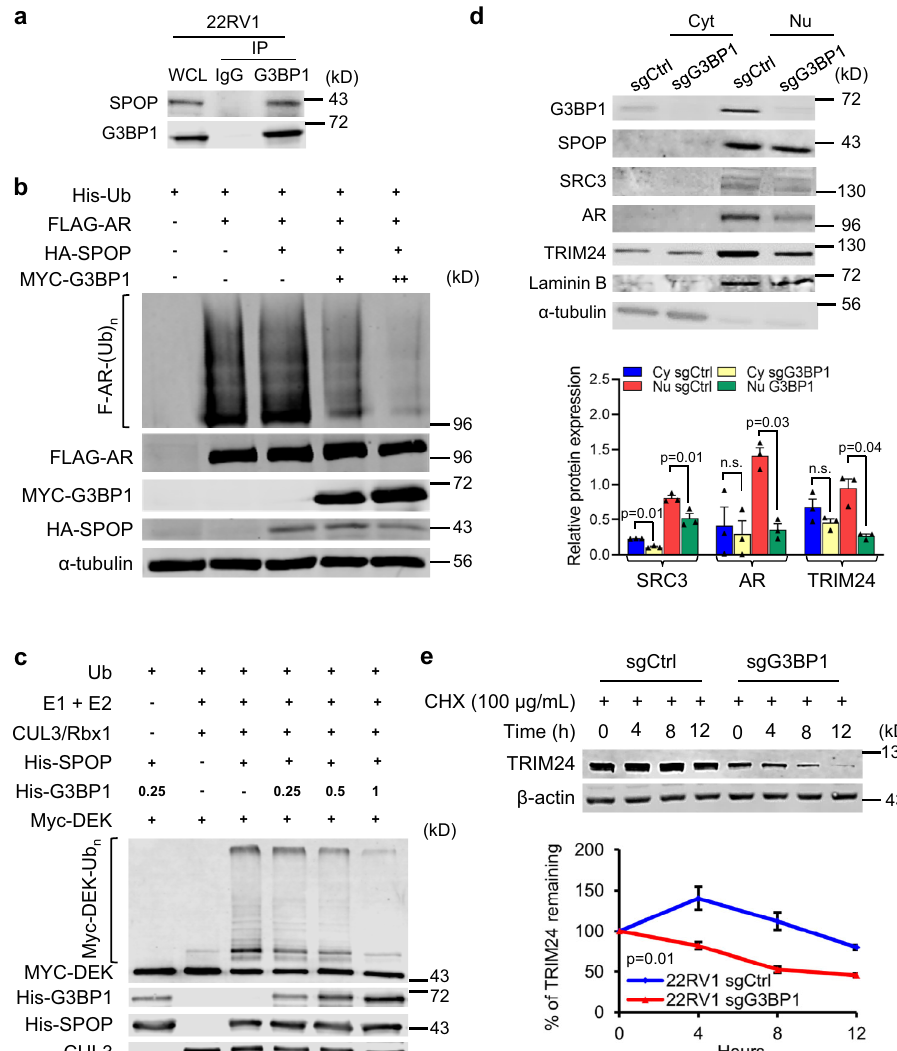
Fig. 1 G3BP1 interacts with SPOP and acts as a negative regulator of SPOP ubiquitin ligase. a 22Rv1 cell lysates were subjected to immunoprecipitation (IP) with IgG and anti-G3BP1 antibody and immunoblotted with anti-SPOP and anti-G3BP1 antibodies. n = 3. b HEK 293T cells were transiently transfected with His-Ub and the indicated construct(s) for 48 h. Cell lysates were subjected to His-Ub pulldown using nickel-NTA beads under denaturing conditions, followed by SDS – PAGE, and immunoblotting with the anti-FLAG antibody. Expression of FLAG-AR, MYC-G3BP1, and HA-SPOP was detected by immunoblotting. α -tubulin served as an internal loading control. n = 3. c DEK ubiquitination (Ub) was reconstituted in vitro using af fi nity-puri fi ed recombinant proteins as indicated. Puri fi ed proteins and ubiquitinated DEK were subjected to immunoblotting with the indicated antibodies. All protein concentrations were in nM except Ub, which was in µ M. n = 3. d Immunoblotting of cytosolic and nuclear fraction of LNCaP-sgCtrl and LNCaP-sgG3BP1 cells with the indicated antibodies. Results from three independent experiments were quantitated by densitometry and relative protein expression of SRC3, AR, and TRIM24 in LNCaP-sgG3BP1 cells relative to those of LNCaP-sgCtrl were plotted. Error bars, ±S.E.M. Paired t -test. e Cycloheximide (CHX)-chase analysis to determine the half-life of endogenous TRIM24 in 22Rv1-sgCtrl and 22Rv1-sgG3BP1 cells. The percentage of TRIM24 remaining was graphed